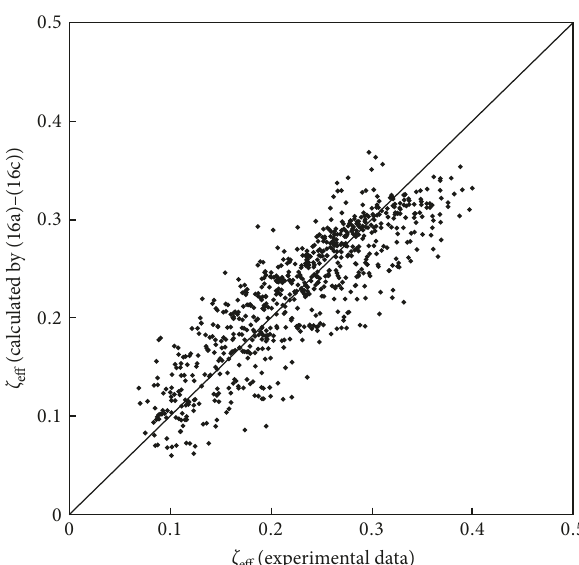
Figure 8: Comparison of the EVD ratio predicted and derived from experimental data.